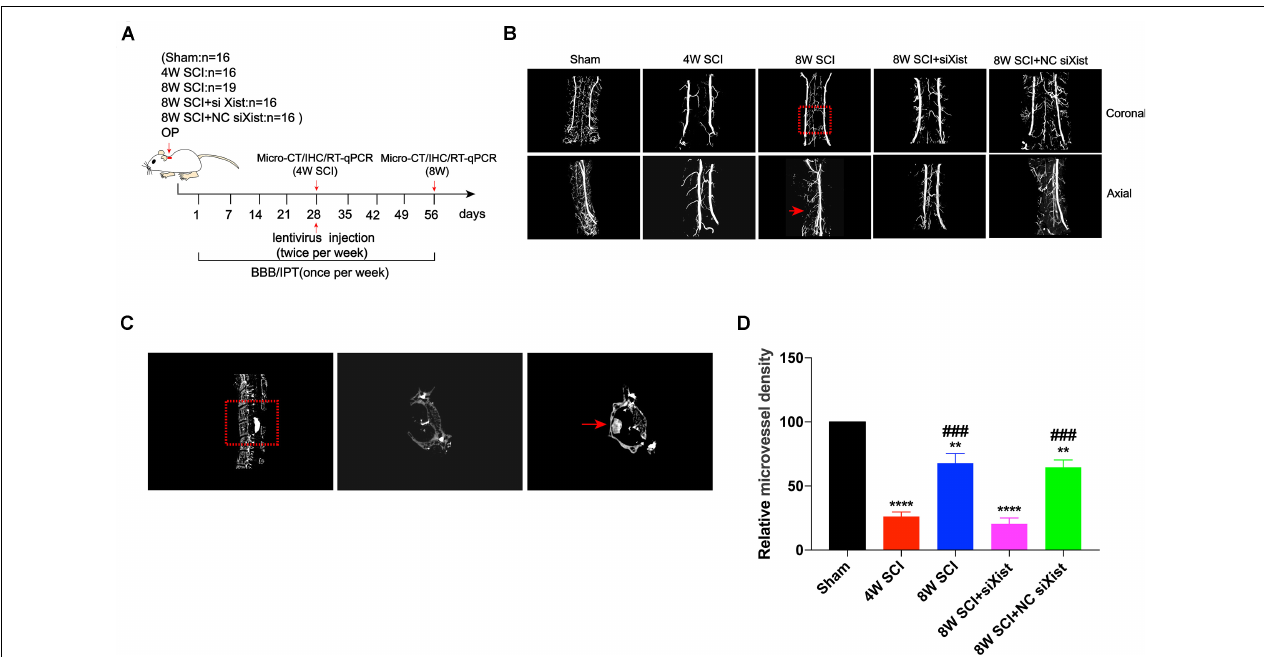
FIGURE 2 | Xist knockdown inhibits angiogenesis after CCSCI. (A) Experimental design. (B) Three-dimensional reconstruction and representative micro-CT images of microvessels of the cervical spinal cord in the sham and SCI groups. The red arrow indicates the compression site of the cervical spinal cord. (C) Representative sagittal and transverse CT images of the resected lamina of C5 and the compression material, respectively (red arrow). (D) Angiogenesis was evaluated by quantitation of the relative microvessel density. ** p < 0.01, **** p < 0.0001 as compared with the sham group; ### p < 0.001 as compared with the 4W SCI group. Data are expressed as the mean ±